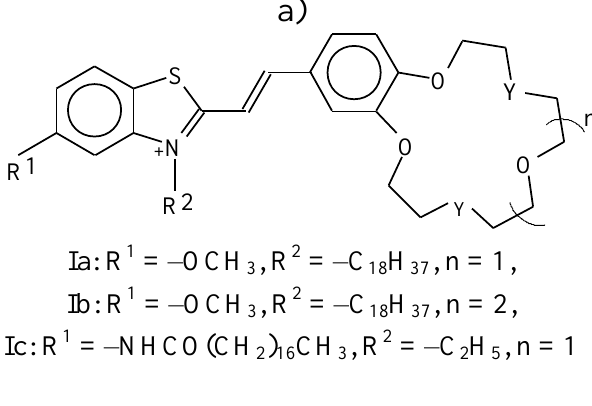
Figure 1. ( a ) Structure of type-I crown-containing styryle dyes (CCDs); ( b ) schematic diagram of the reversible trans-cis isomerization of crown ether molecule; ( c ) structure of butadienyl derivatives of crown ethers (BDCE); and ( d ) structure of type-II crown-containing styryle dyes (CCD). a)